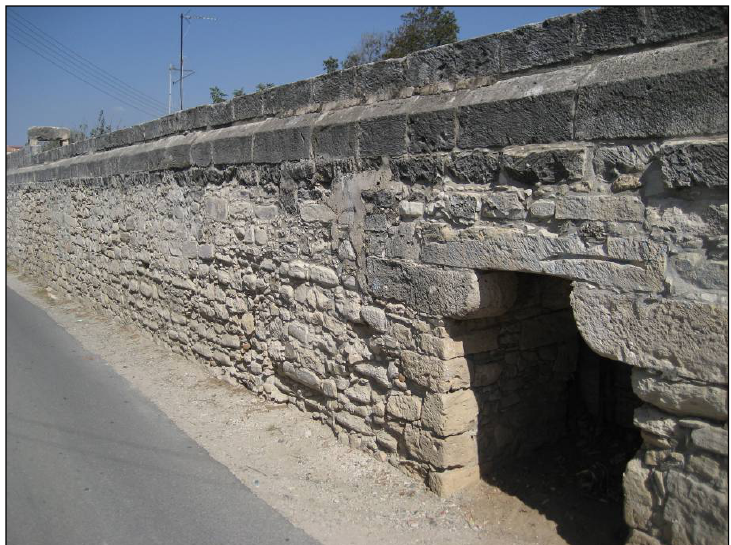
Figure 17. Aqueduct supplying the cane mill at Kolossi,